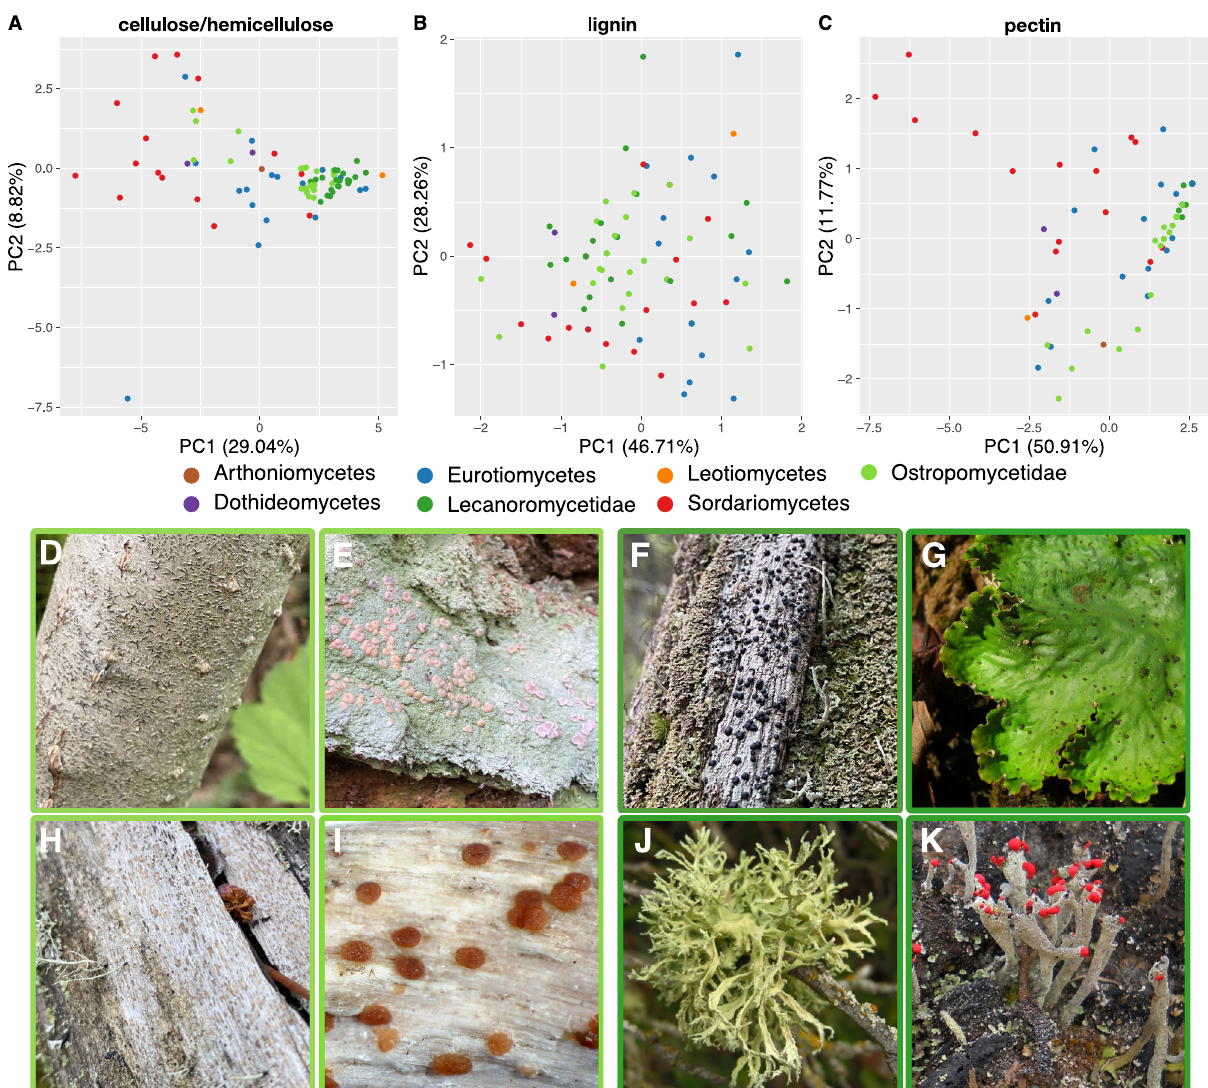
Fig. 2 Similarity of CAZyme sets involved in the breakdown of different complex plant-based polysaccharides based on phylogenetically corrected Principal Components Analysis. Different colors indicate taxonomic groups; genomes from the subclasses Acarosporomycetidae and Umbilicariomycetidae use the same color codes as Lecanoromycetidae for simplicity. A Similarity of CAZyme families involved in cellulose and hemicellulose breakdown. B Similarity of CAZyme families involved in lignin breakdown, C Similarity of CAZyme families involved in pectin breakdown. Displayed below are representative members of the two subclasses Ostropomycetidae (with light green border) and Lecanoromycetidae (dark green border). D Graphis scripta , E Icmadophila ericetorum , F Mycoblastus sanguinarius , G Peltigera leucophlebia , H Xylographa carneopallida , I Agyrium rufum , J Evernia prunastri , K Cladonia macilenta . Image credits: Agyrium rufum : Paul Cannon (fungi.myspecies.info); Creative Commons: BY-NC 4.0. Peltigera leucophlebia : Jason Hollinger, uploaded by Amada44, CC-BY 2.0, https://commons.wikimedia.org/w/index.php?curid = 24213606. Evernia prunastri : by Jason Hollinger, CC-BY 2.0, https://commons.wikimedia.org/w/index.php?curid = 50595319. Cladonia macilenta : Bruce McCune & Sunia Yang - Lichen, CC-BY 4.0-NC,